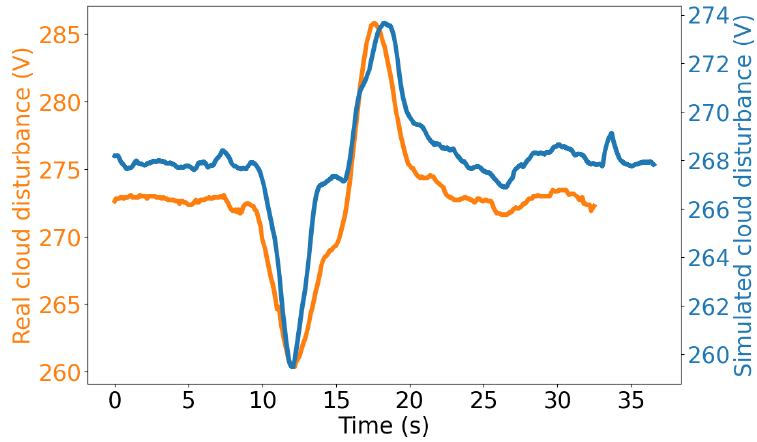
Figure 14. System voltage disturbance with real and simulated Cloud 2.